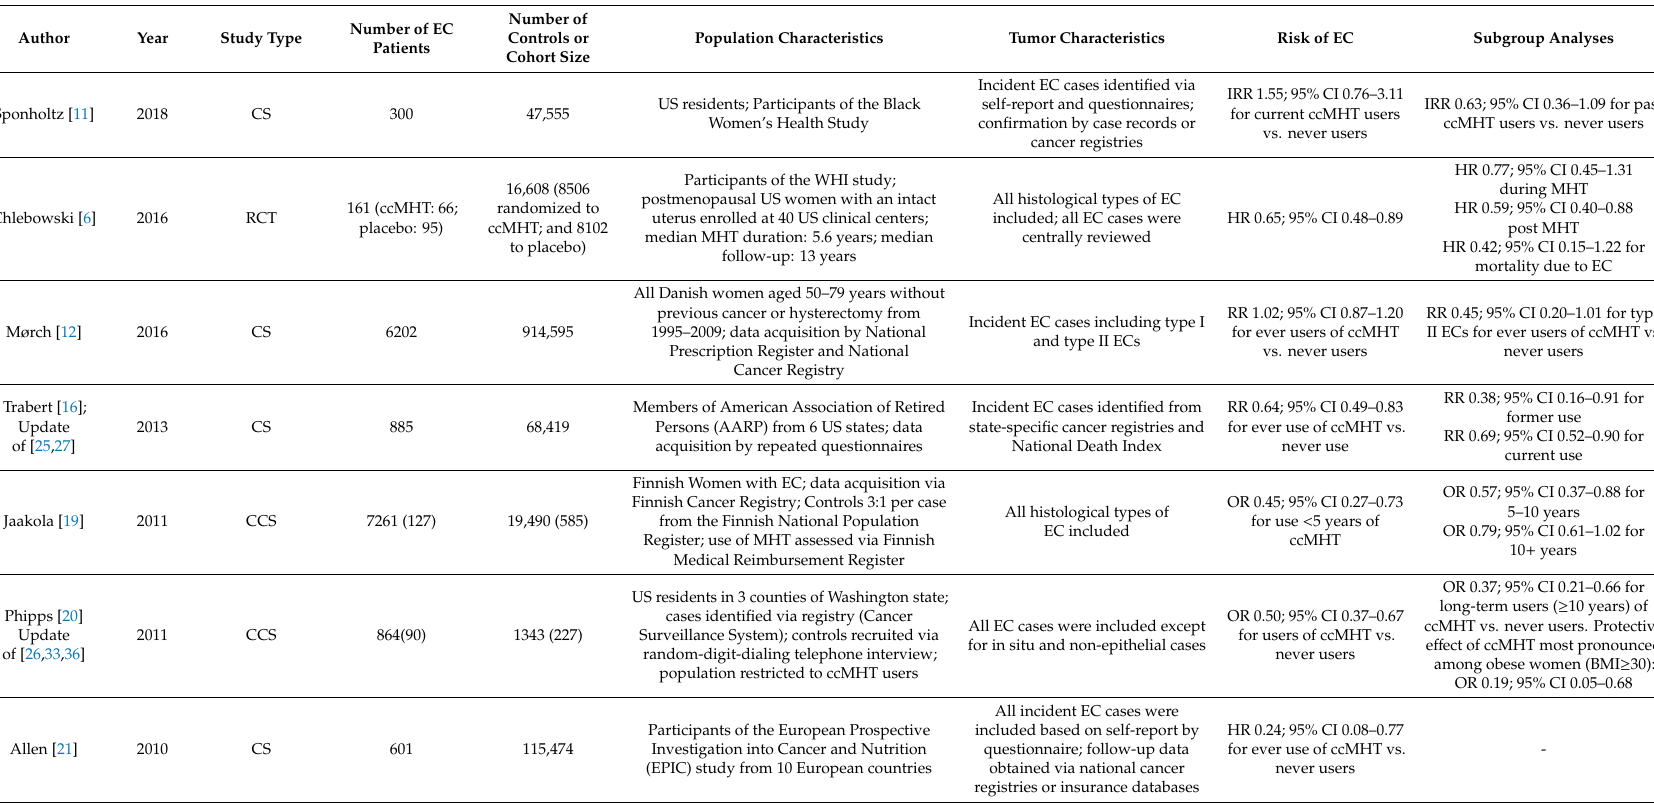
Table 1. Clinical Characteristics of Studies Reporting on Continuous Combined Menopausal Hormone Therapy (ccMHT) with Synthetic Progestins and Endometrial Cancer (EC)